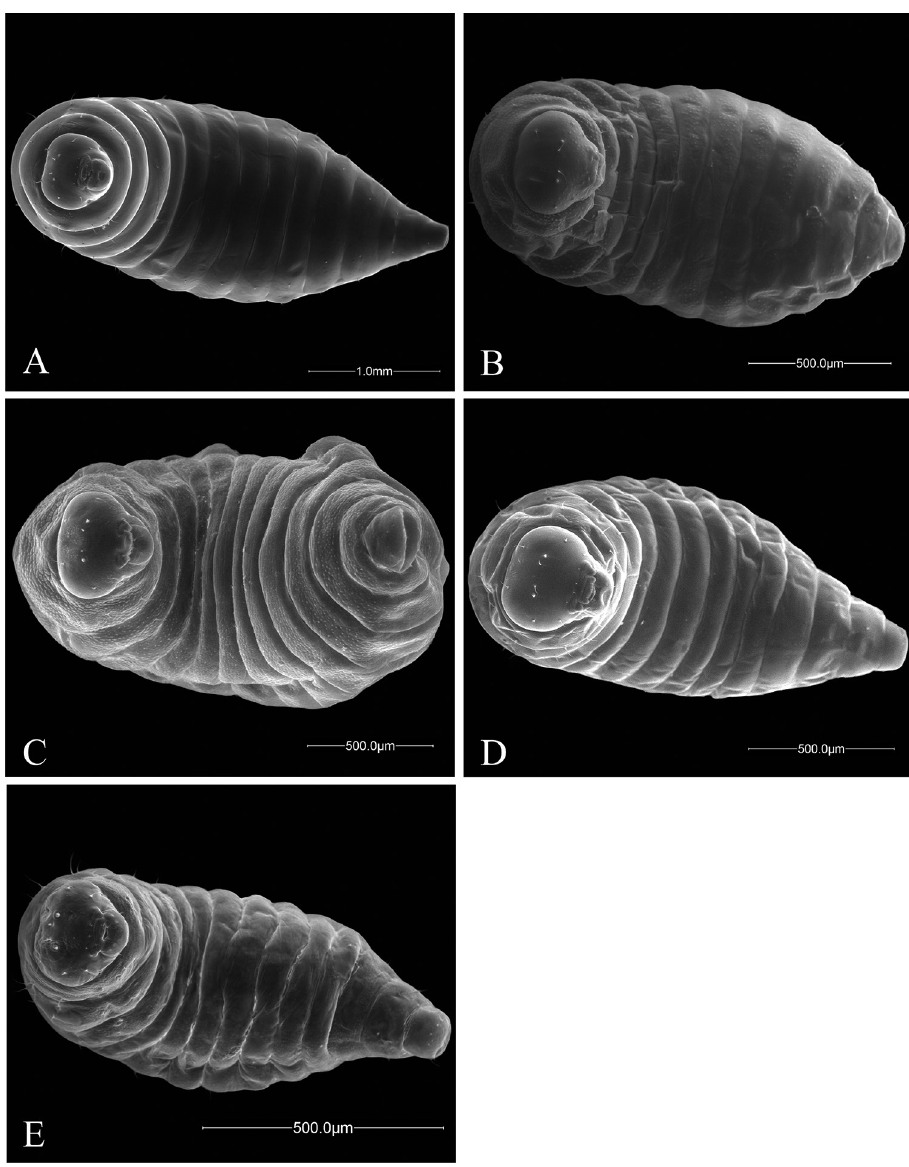
Figure 4. Ventral views of Ormyrus terminal-instar larvae. A Ormyrus papaveris B O. pomaceus ex Trigo- naspis mendesi (Cynipidae) C O. pomaceus ex Plagiotrochus razeti (Cynipidae) D O. rufimanus E O. wachtli .